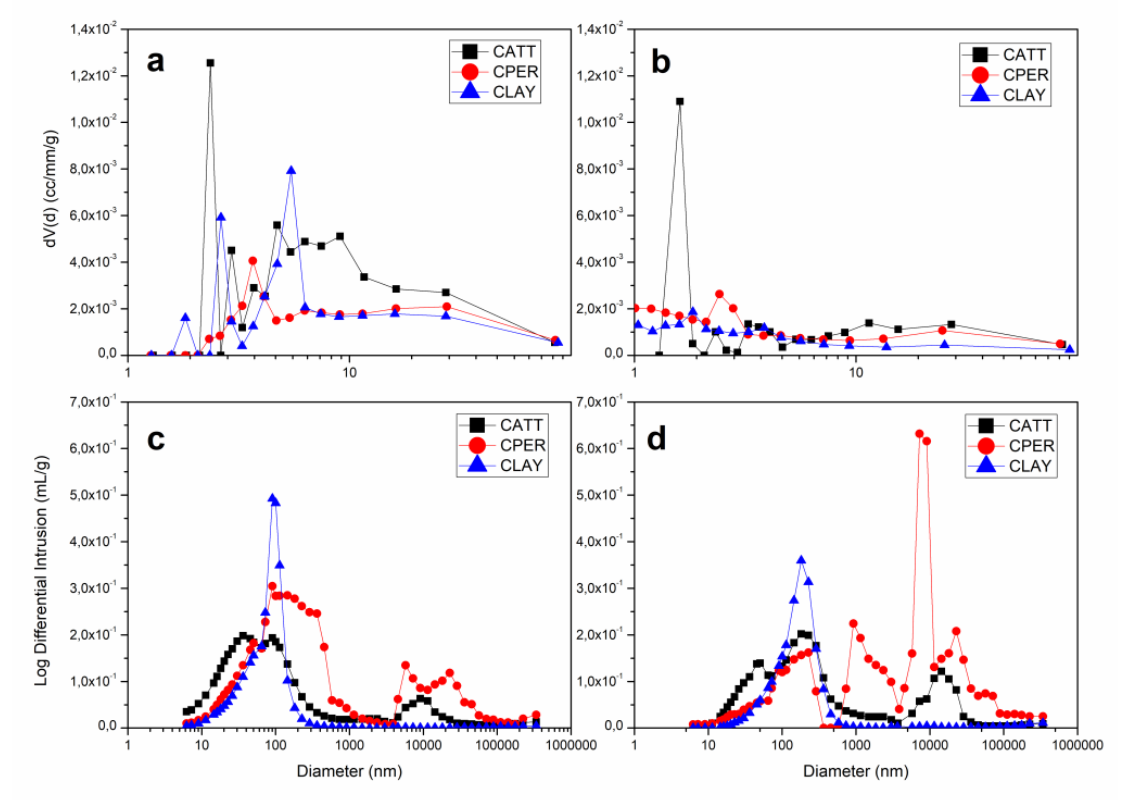
Figure 6. Pore size distribution from nitrogen adsorption test: ( a ) samples sintered at 800 °C and ( b ) samples sintered at 1000 °C and from mercury intrusion test: ( c ) samples sintered at 800 °C and ( d ) samples sintered at 1000 °C. Table 2. N 2 adsorption measurements for CATT, CPER and CLAY samples at different firing temperatures.